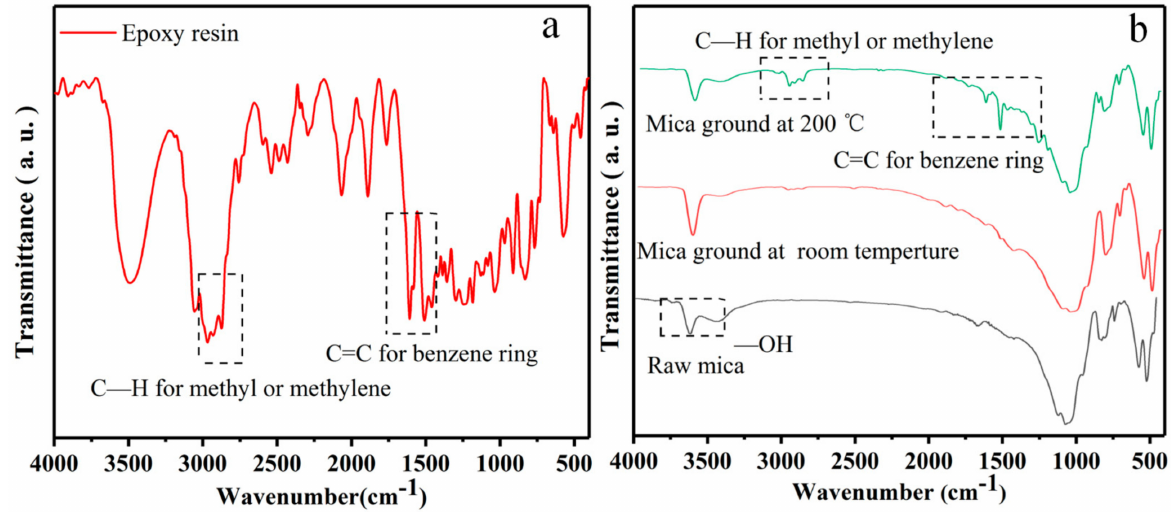
Figure 2. The FTIR spectrum of ( a ) epoxy resin and ( b ) mica under different